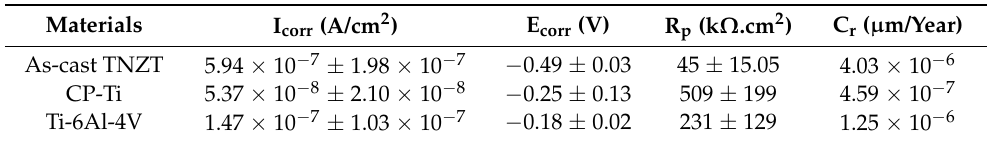
Table 3. Kinetic parameters obtained by the polarization curves (PPCs) in Figure 8. First, an average of the parameters of the three curves was made and the final result can be found in this table. The R p values were obtained by Equation (3).